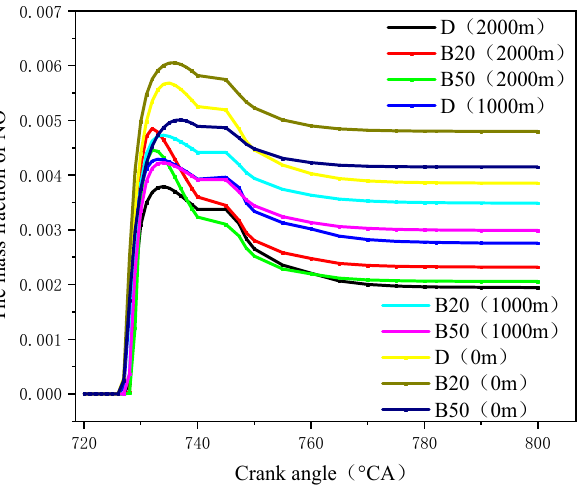
Figure 7. Effect of different plateau environments on NO emissions of diesel with different blending ratios.